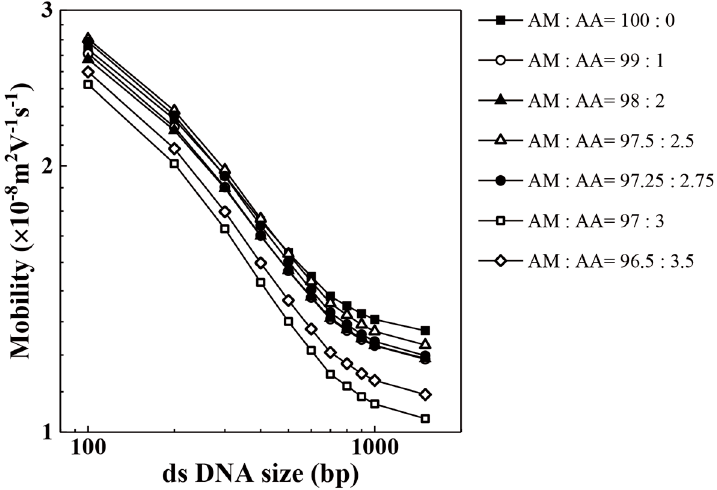
Figure 6. Relationships between double-stranded DNA (ds DNA) mobility and size for poly(AM- co -AA) coatings with different AA contents.